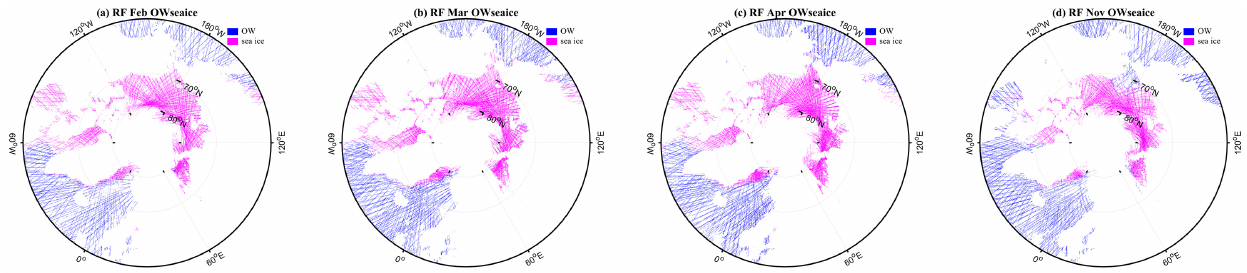
March, ( c ) April, and ( d ) December are used as the test set in turn. Figure A4. RF for OW-sea ice classification using the data in November as the training set. The data in ( a ) February, ( b )